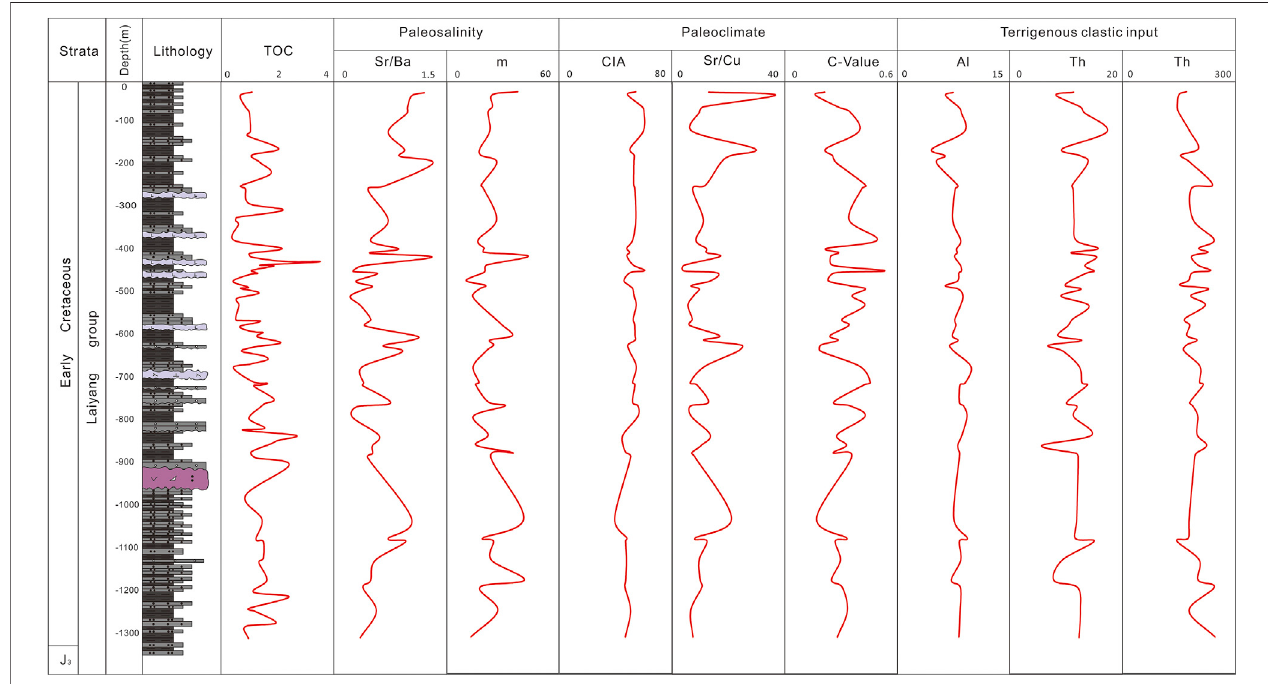
FIGURE 6 | Stratigraphic distribution of TOC, paleosalinity proxies, paleoclimate proxies, and terrigenous clastic proxies, in well LK-1.